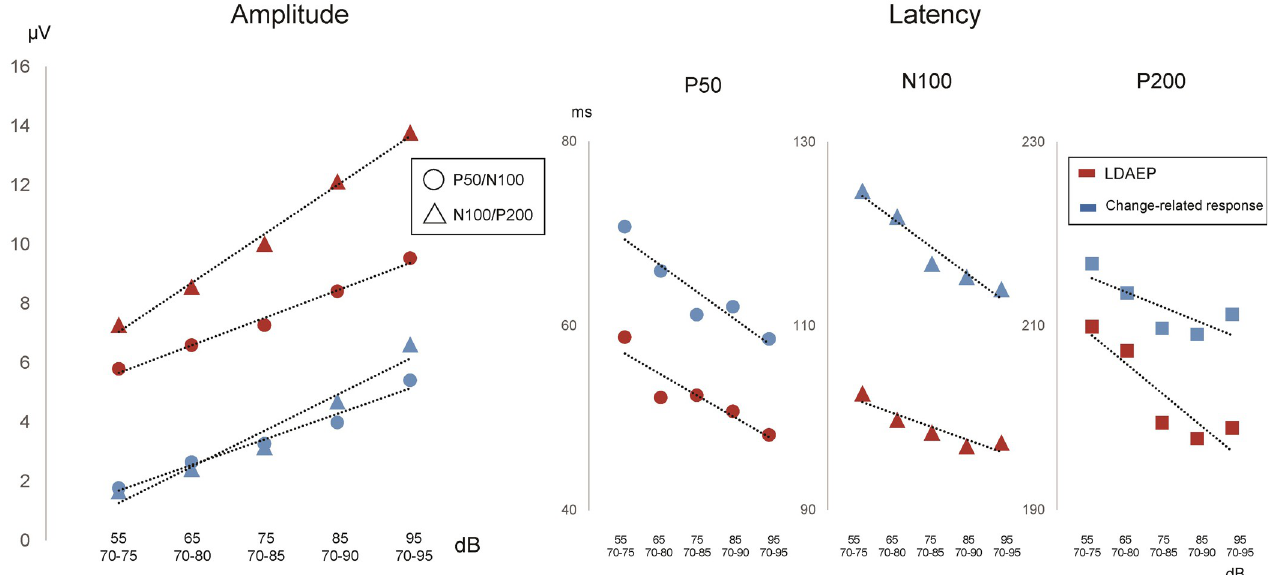
Fig 3. Amplitude and latency for LDAEP and the change-related response. LDAEP and the change-related response are shown aligned. On the right are the P50/N100 and N100/P200 amplitudes corresponding to sound pressure and sound pressure changes, respectively, and on the left are the P50, N100, and P200 latencies corresponding to sound pressure and sound pressure changes.